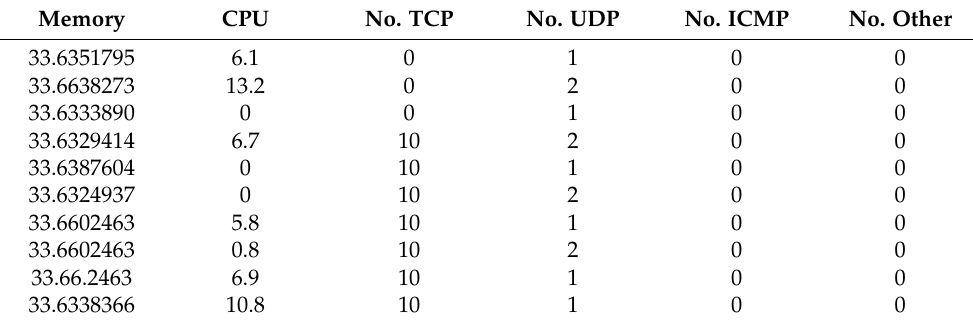
Figure 7. Schematic diagram of packet traffic features capturing and packet delivering. Table 2. The packet traffic dataset.